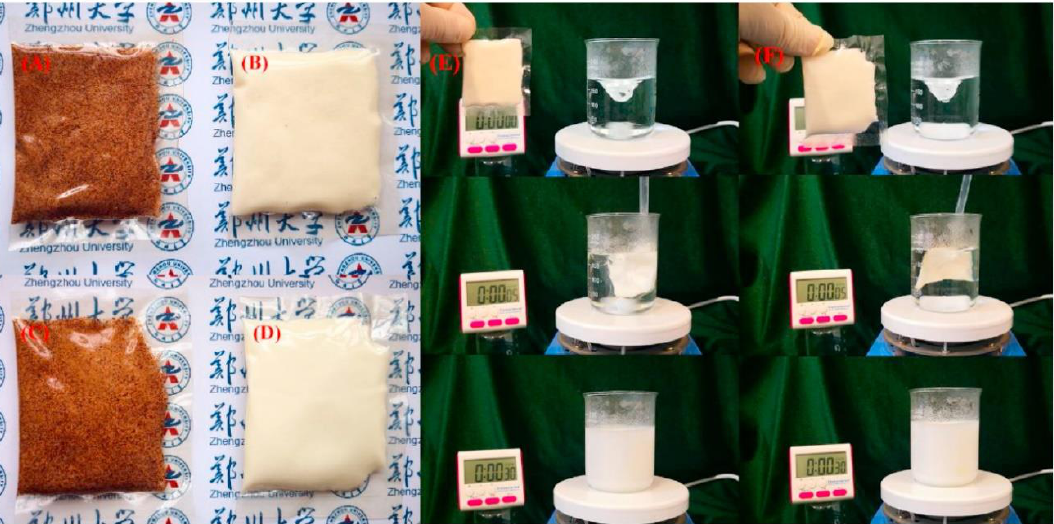
Figure 7. Heat sealable soluble soybean polysaccharide (SPSS)/gelatin blend edible films for food packaging applications. Film ( A , B ) with instant coffee powder and ( C , D ) with coconut powder are SSPS/gelatin blend film pouch with weight ratios of 100/0 (S100G0) and 60/40 (S60G40) respectively. ( E ) coconut powder in S100G0 pouch and ( F ) coconut powder in S60G40 pouch during the dissolution tests in hot water (95 ± 2 °C). Reproduced with permission from [30]. (Copyright 2020 Elsevier).